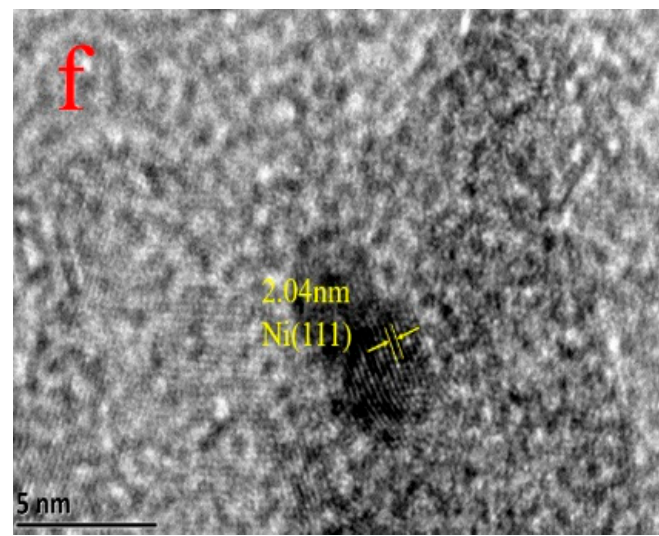
Figure 2. TEM images of ( a ) Ni 10 Mo 2.5 Al, ( b ) Ni 10 Mo 5 Al, ( c ) Ni 10 Mo 10 Al, ( d ) Ni 10 Mo 15 Al and ( e ) Ni 10 Mo 20 Al; and ( f ) HRTEM image of Ni 10 Mo 10 Al catalyst after reduction at 450 ◦ C.